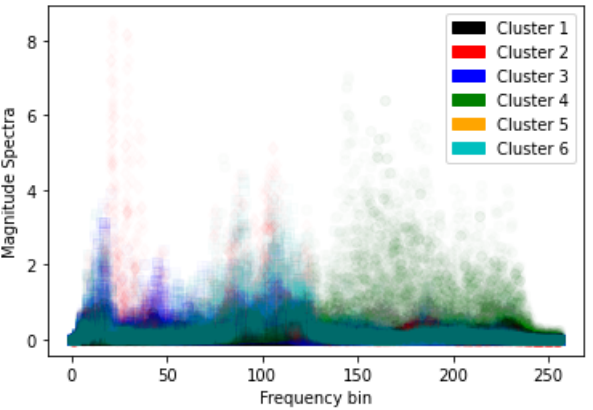
Figure 14. Clustering of spectral information from 600 phrases ( k =